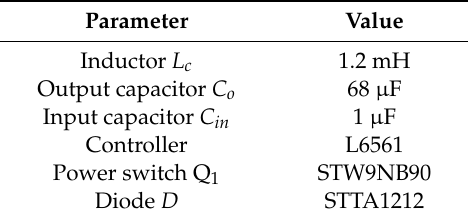
Table 3. PFC stage parameters.